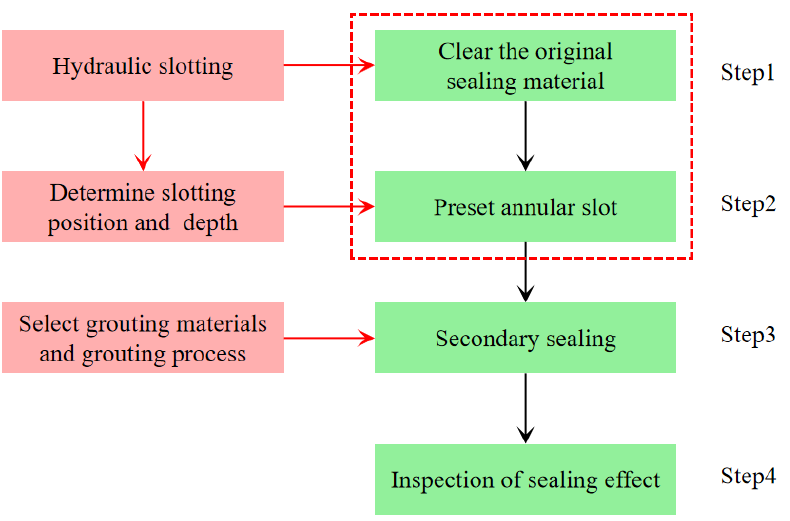
Figure 8. Repair process of failed gas-extraction boreholes.